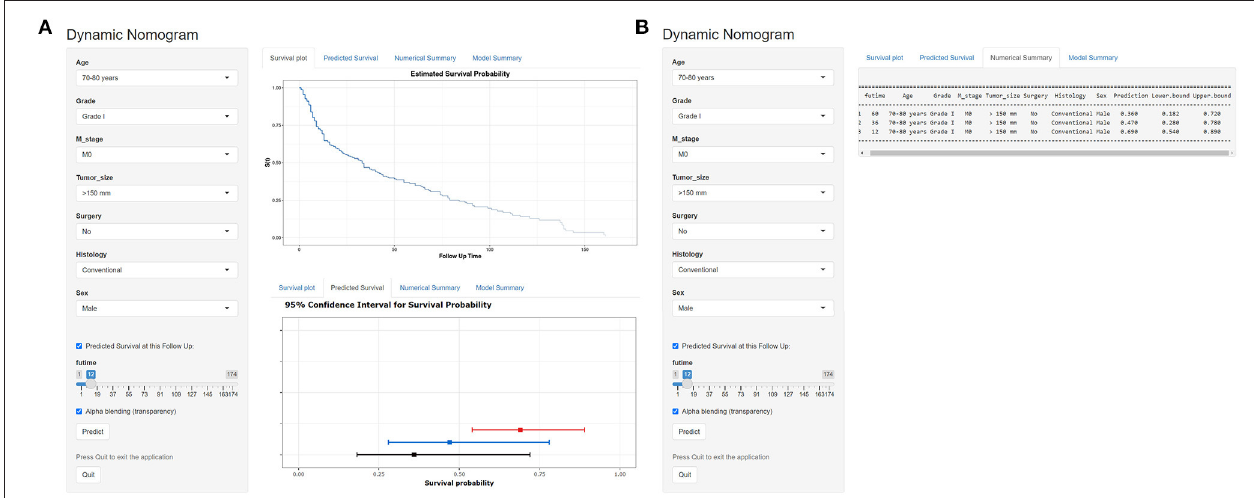
FIGURE 9 | Operation interface of nomogram on web page. After entering a patient’s age, sex, M stage, tumor size, surgery, histology, and grade on the web, a clinician can ascertain a patient’ s OS, survival probability. (A) The graphical summary of predicted OS and 95% CI at 12 months (red), 24 months (blue), and 36 months (black). (B) The specific numbers of survival